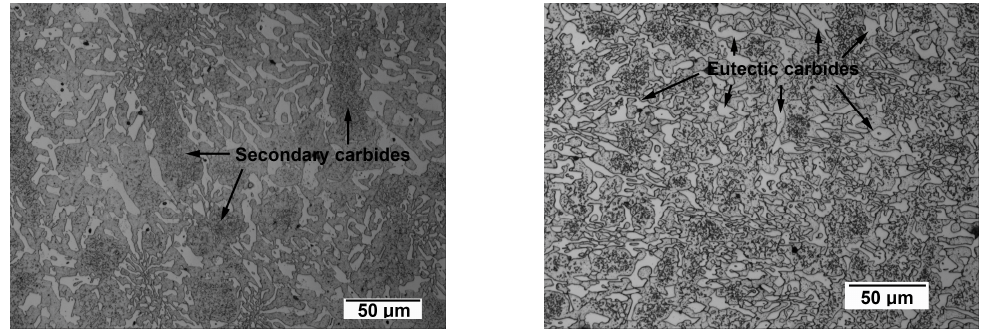
Figure 3. Microstructure after the different treatments for destabilizing the austenite. Optical microscope: 500 magnifications.